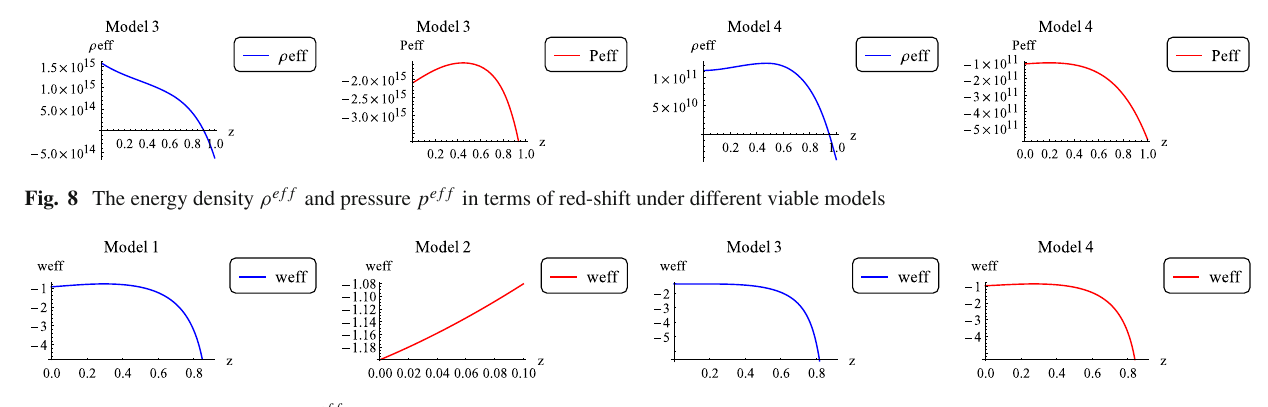
Fig. 7 The energy density ρ ef f and pressure p ef f in terms of red-shift under different viable models